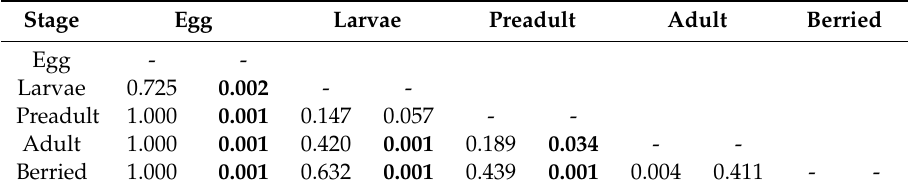
Table 1. Community dissimilarity test of gut microbiota over crayfish developmental stages based on analysis of similarity (ANOSIM) using Bray–Curtis distance.